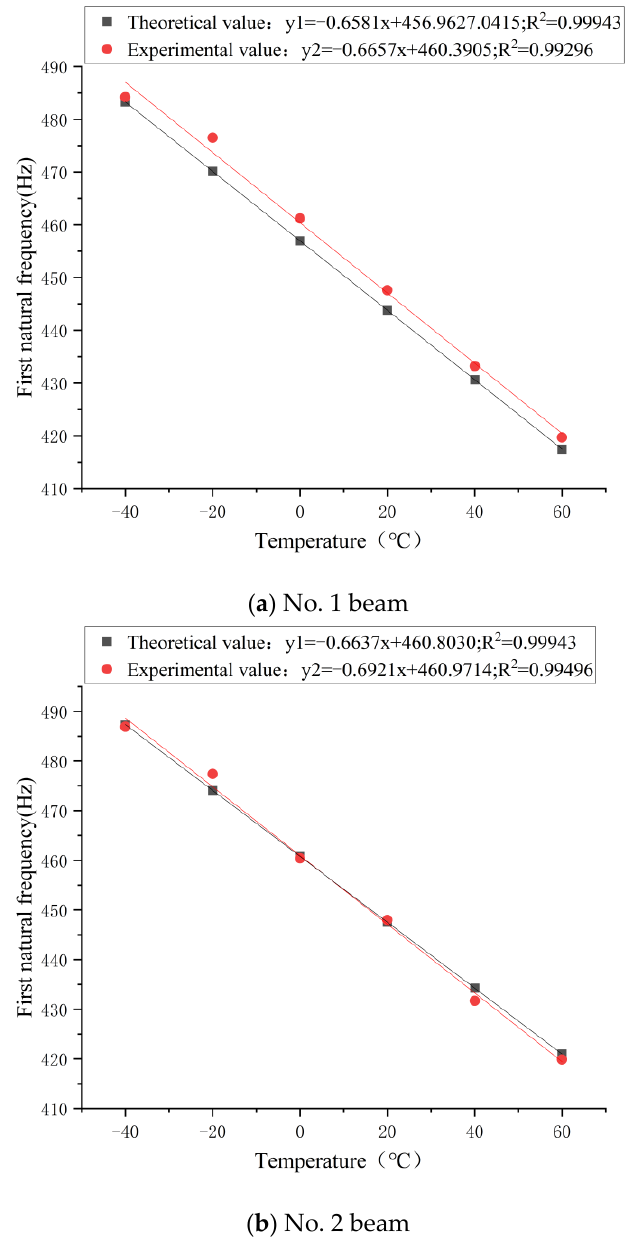
Figure 5. Relationship between theoretical results of the testing beam and experimental results of the first-grade natural frequency with temperature change.